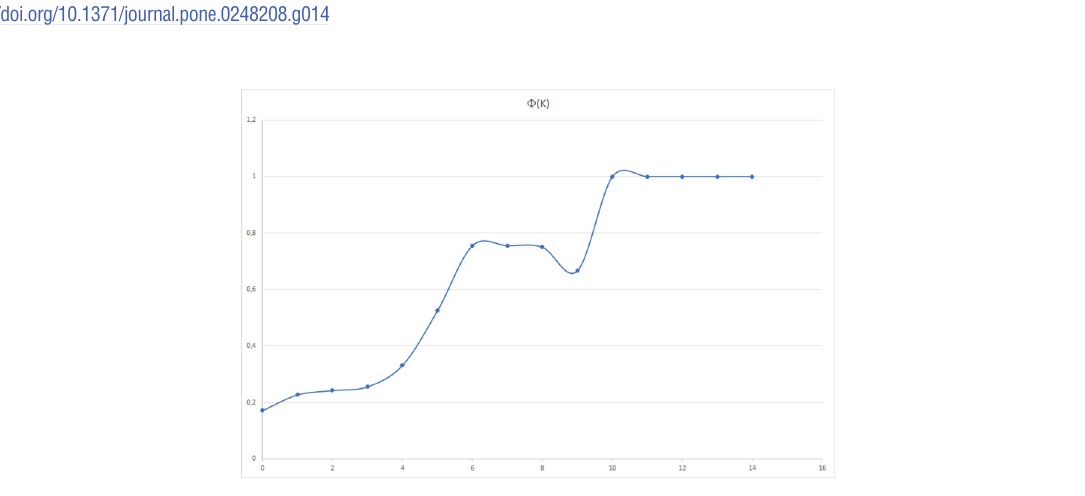
Fig 15. Motifs differing significantly between a random graph and the study plan graph.